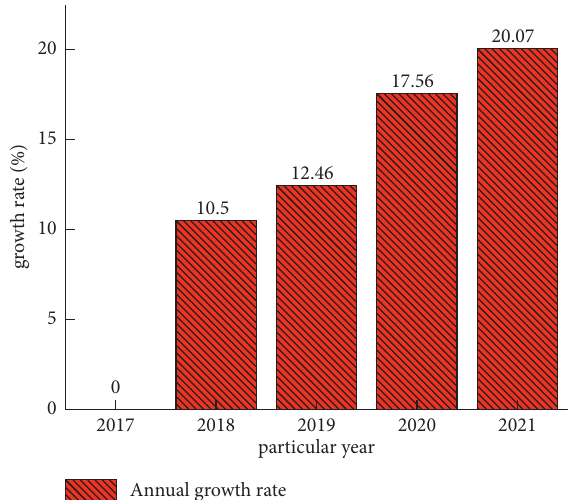
Figure 9: Annual growth rate of industry revenue.